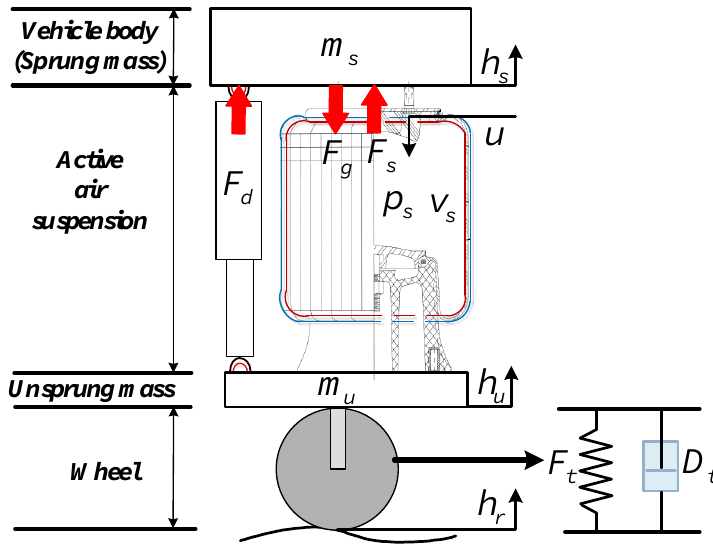
Figure 1. Schematic diagram of quarter vehicle with active air suspension